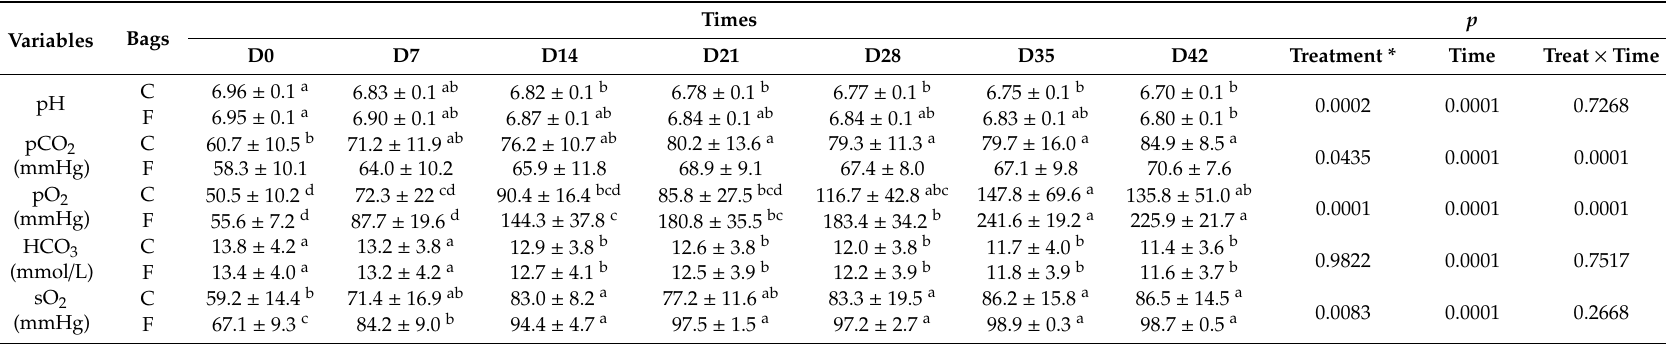
Table 2. Mean values and standard deviations of the blood gas variables of the cattle whole blood stored in CPD / SAG-M (C) and CPD / SAG-M with Filter (F) bags for 42